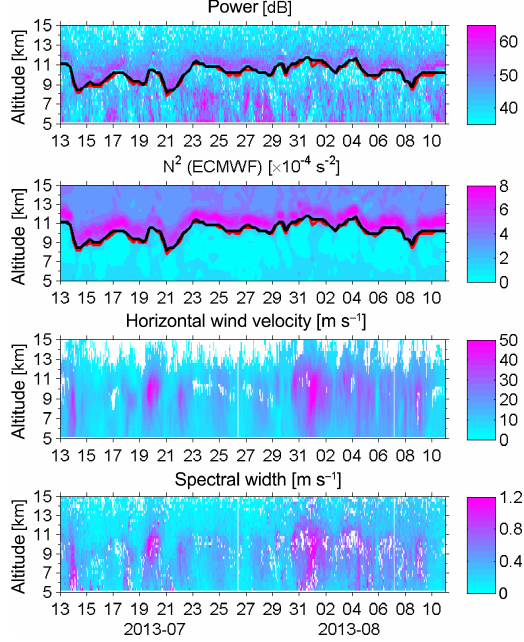
Figure 2. Height–time cross sections of echo power from the radar measurements with MAARSY and temperature derived from the ECMWF reanalysis data as well as horizontal winds and spectral widths with MAARSY from the uppermost to lowermost panels, respectively, during the period of 13 July–10 August 2013. The lines (in the upper two panels) indicate the tropopause height ac- cording to temperature profiles from ECMWF: red line for lapse rate tropopause (LRT) and black for cold point tropopause